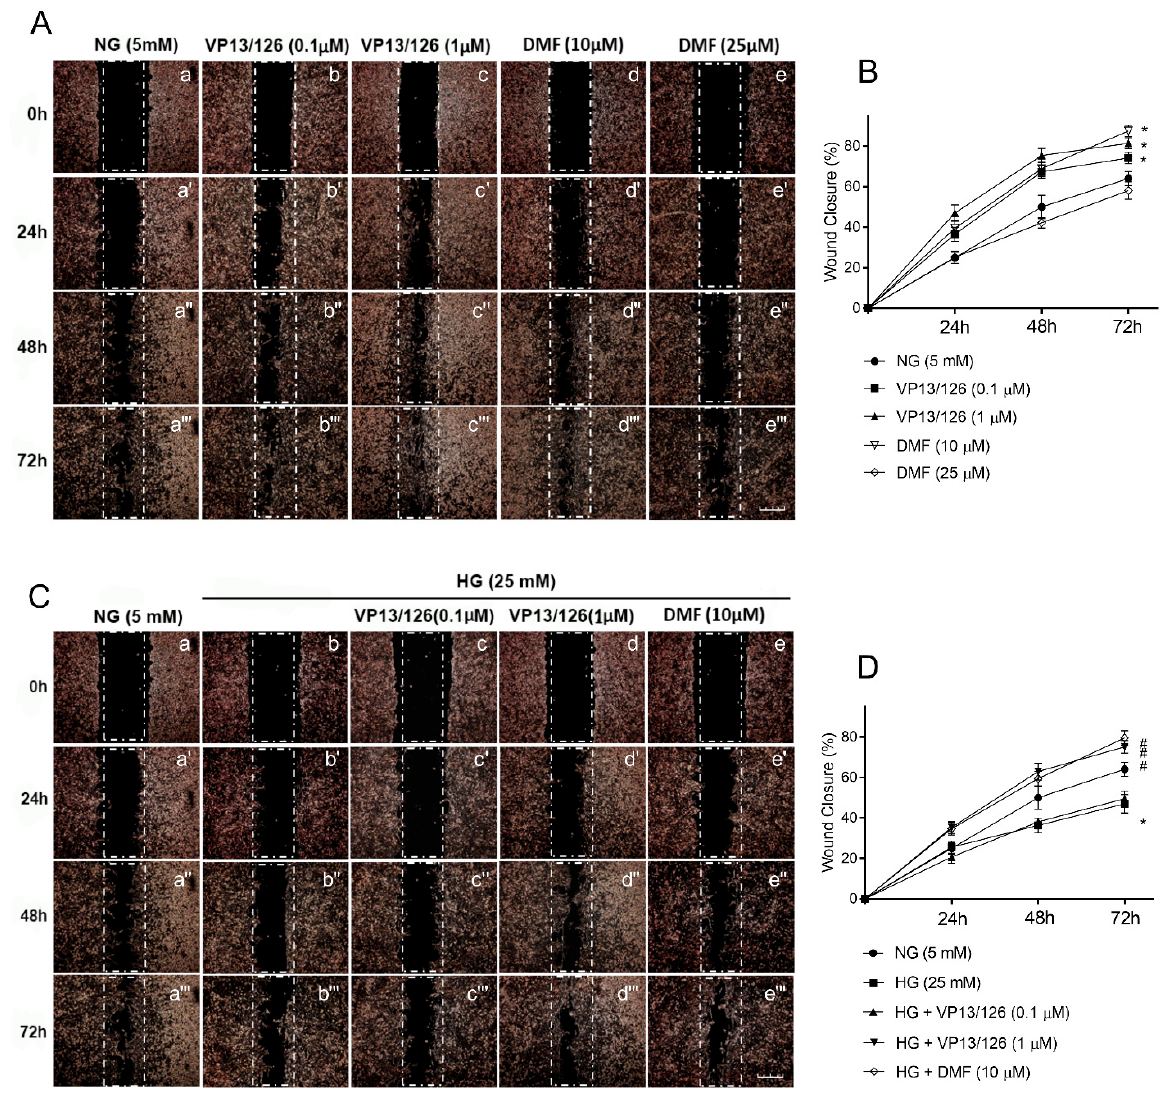
Figure 4. Promoting effects of VP13/126 on cell migration in SIRC challenged with high glucose (HG). ( A ): representative images of wound healing assays performed in normal glucose (NG) treated-cells with or without 0.1 and 1 µ M of VP13/126 or 10 and 25 µ M of DMF immediately after the scratch at 0 h ( a – e ), at 24 h ( a’ – e’ ), at 48 h ( a” – e” ) and at 72 h of incubation ( a”’ – e”’ ), respectively). ( B ): relative quantification of wound closure percentage carried out in NG conditions. ( C ): representative images of wound healing assays performed in NG cells, in HG-treated cells and in co-treated cells with HG plus 0.1, and 1 µ M of VP13/126 and 10 µ M of DMF immediately after the scratch at 0 h ( a – e ), at 24 h ( a’ – e’ , respectively), at 48 h ( a” – e” ) and at 72 h of incubation ( a”’ – e”’ , respectively). ( D ): relative quantification of wound closure percentage carried out in HG conditions. All images were acquired with a Leica microscope using a 20X magnification; scale bar = 200 µ m. Data are shown as mean ± SEM of n = 3 independent experiments. * p < 0.05 vs. Ctrl; # p < 0.05 vs. HG alone in the respective conditions. Two-way ANOVA, followed by Tukey’s test.